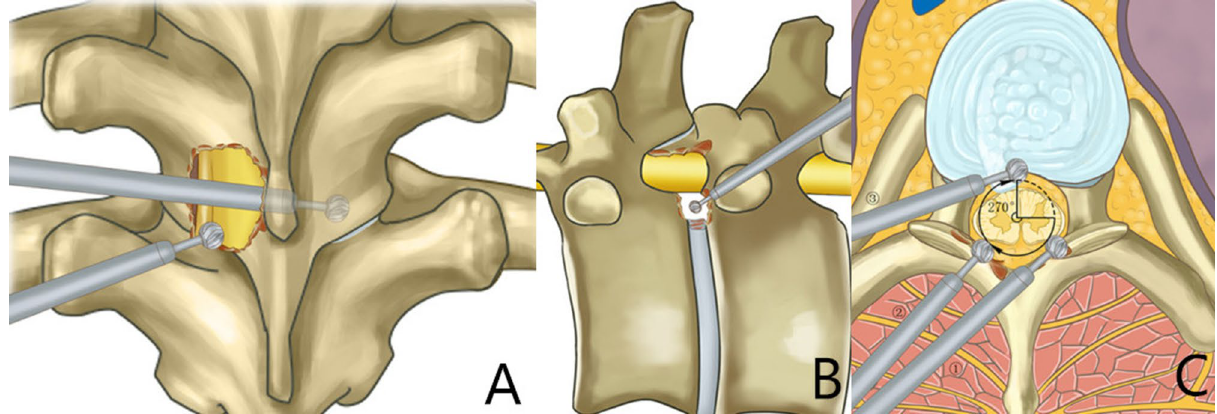
Figure 1. Illustration of the critical process in 270° decompression technique of spinal endoscopy. ( A ) The window of the posterior approach vertebral plate was opened. First, contralateral decompression was performed and then ipsilateral decompression was performed. ( B ) The posterolateral approach was used to remove the ventral disc and part of the vertebral bone; ( C ) The percutaneous spine endoscopic technique accomplished phase I compression in the ventral and dorsal dura mater using 270° decompression.